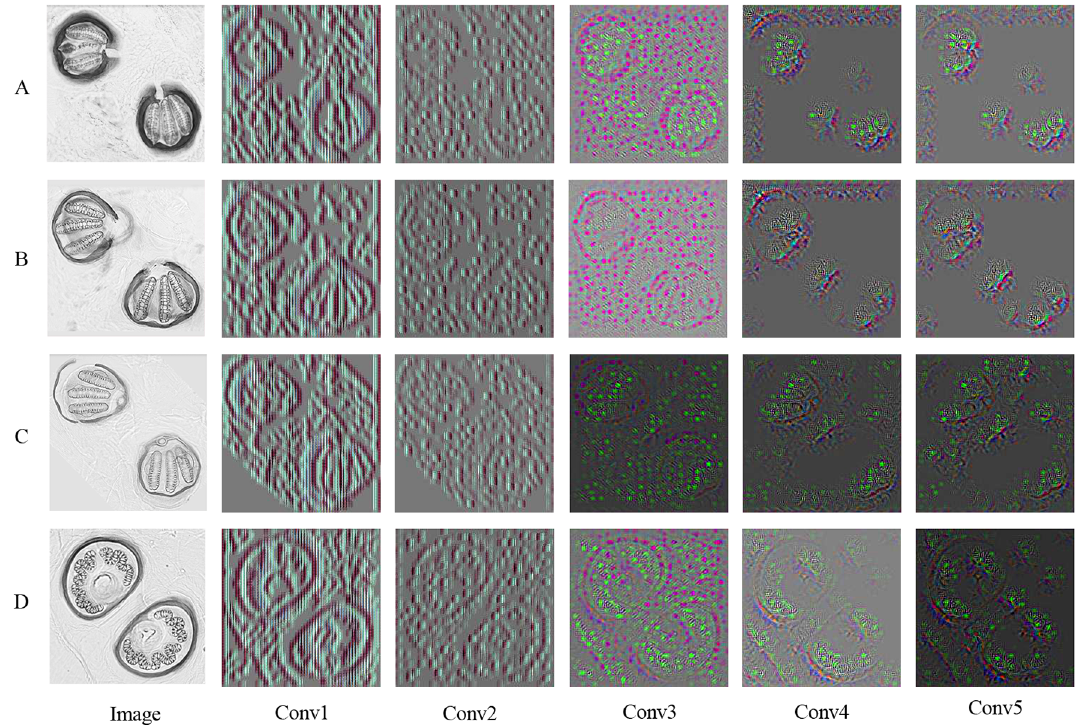
Figure 4. Visualization of hidden convolutional layers in AlexNet for four example images (To clearly show the patterns, we generated the color images; ( A ) Chrysomya ( Achoetandrus ) ruffifacies , ( B ) Chrysomya megacephala , ( C ) Lucilia cuprina , ( D ) Musca domestica ).